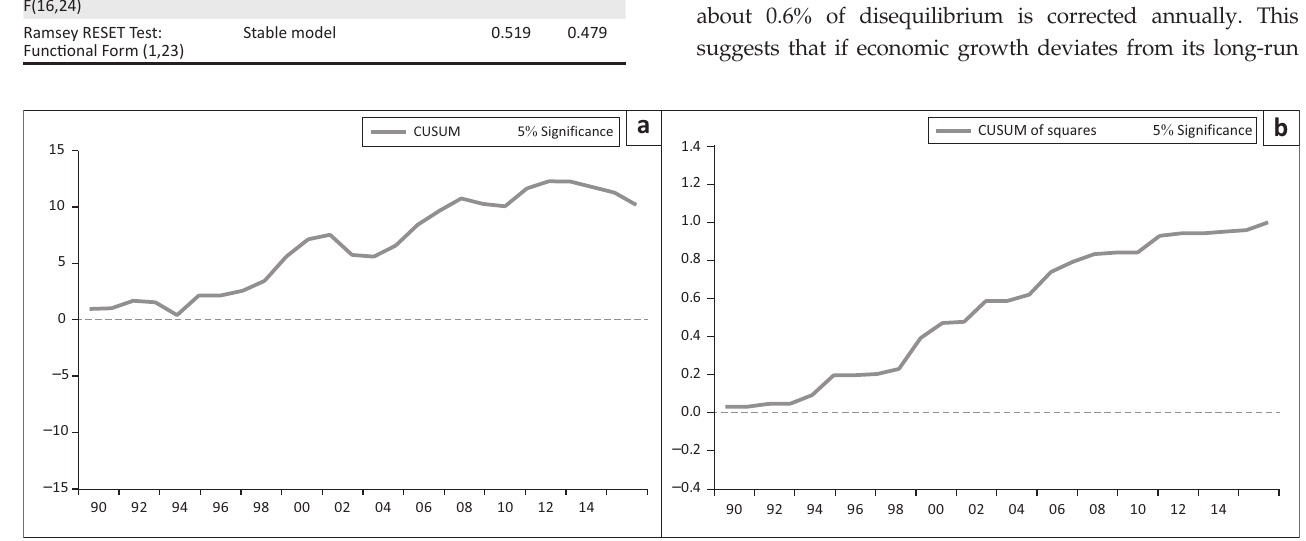
FIGURE 2: Stability Test – Cumulative sum and cumulative sum squared. (a) Plot of cumulative sum of recursive residuals. (b) Plot of cumulative sum of squares recursive residuals.